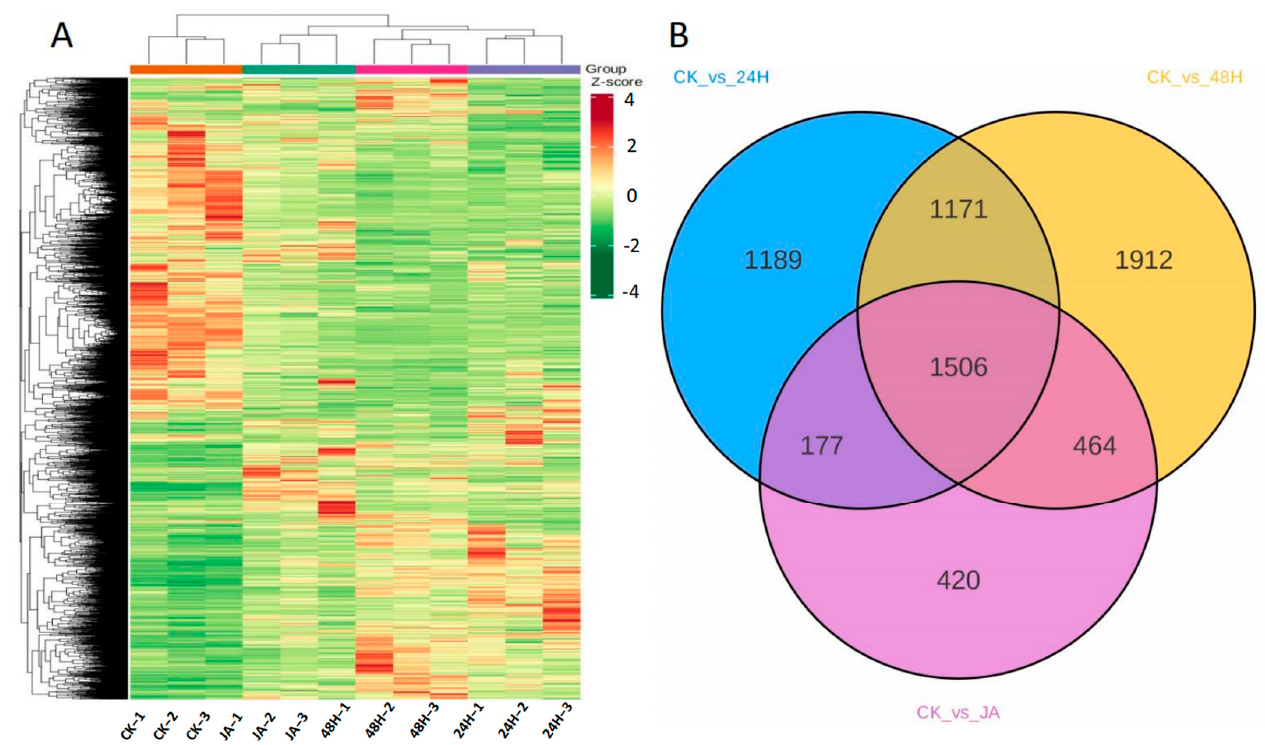
Figure 3. ( A ) Hierarchical cluster analysis. Different columns in the figure represent different samples, and different rows represent different genes. The colors from blue to yellow indicate increasing gene expression levels. ( B ) Venn diagram of DEGs detected in CK vs. 24H, CK vs. 48H, and CK vs. JA.